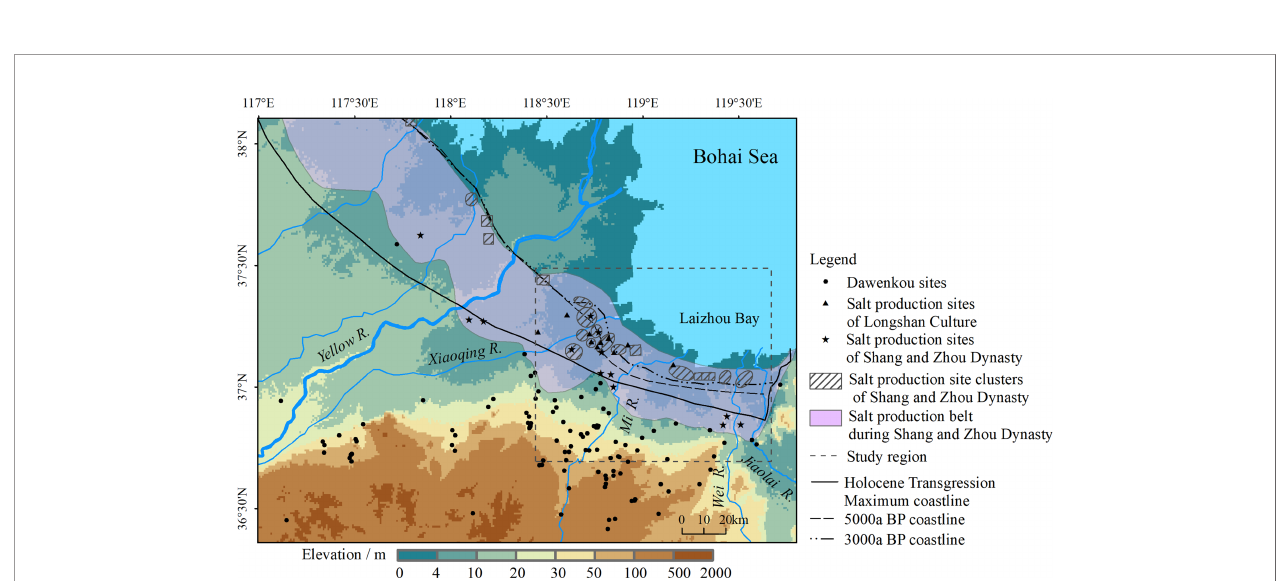
FIGURE 6 | Distribution of the Dawenkou cultural sites, and the salt production sites of the Longshan cultural period and the Shang and Zhou